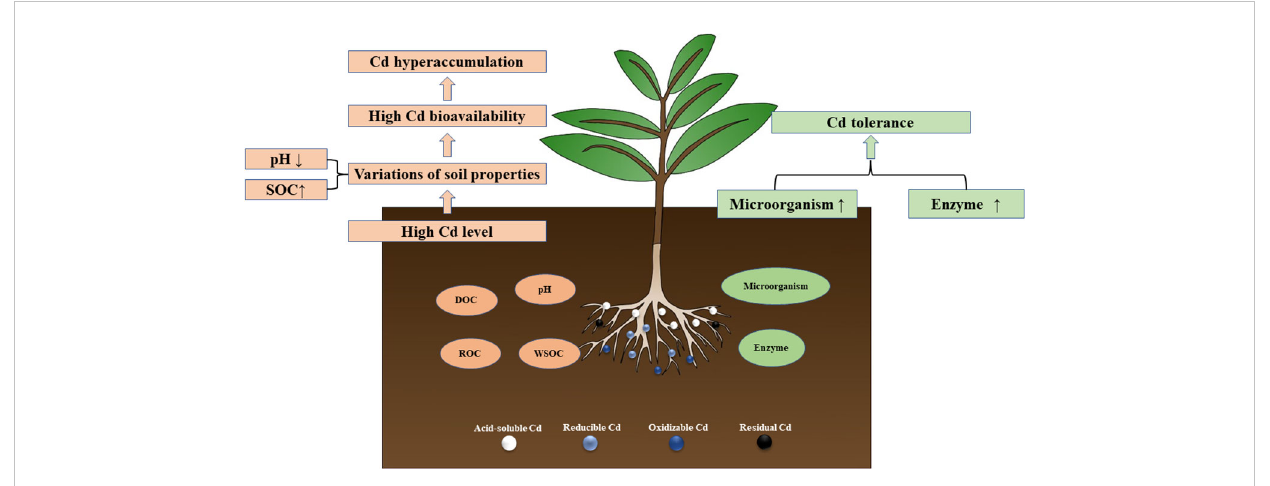
FIGURE 8 Schematic of the mechanism of the activation and tolerance of S. orientalis